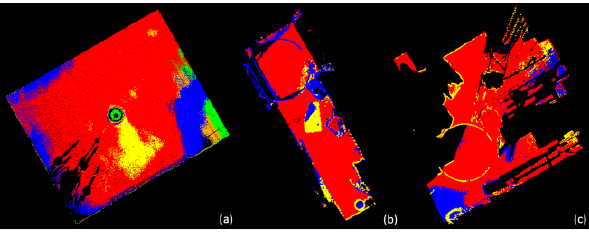
Figure 7. (a) A ceiling of a room, (b) a floor of a balcony, (c) a floor of a room.